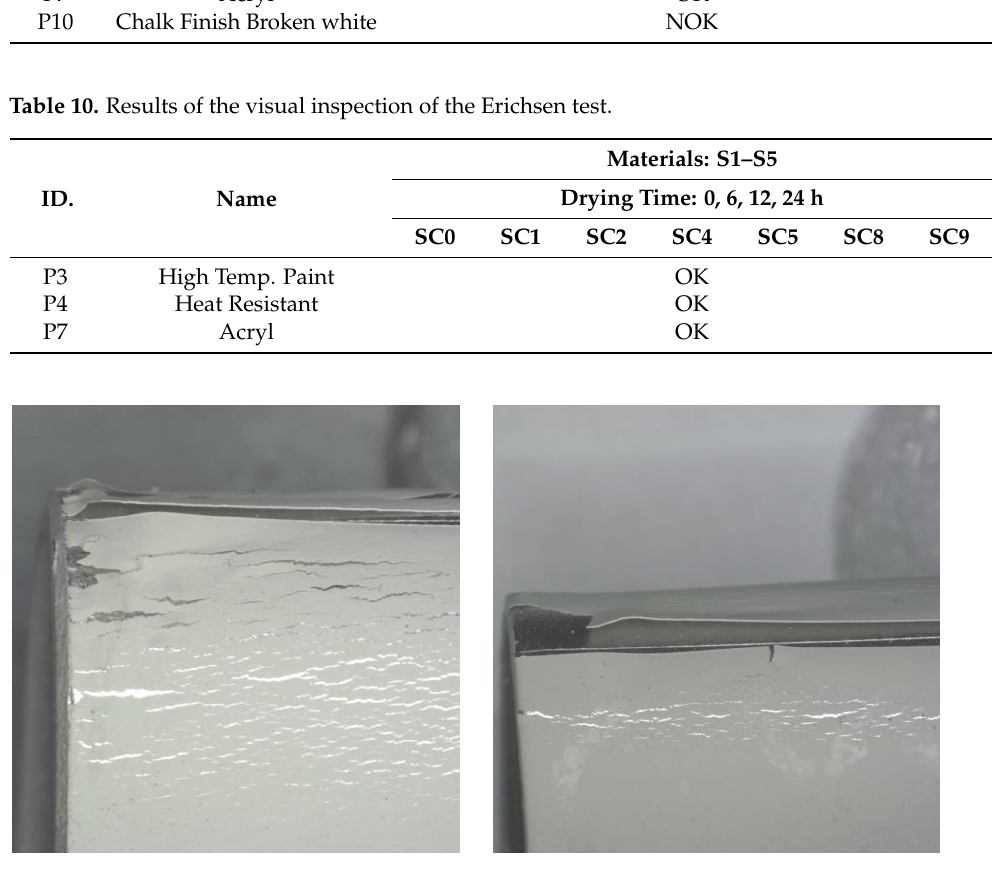
Figure 13. Microscope images of P5 and P10 paints. Table 9. Results of the bending test.